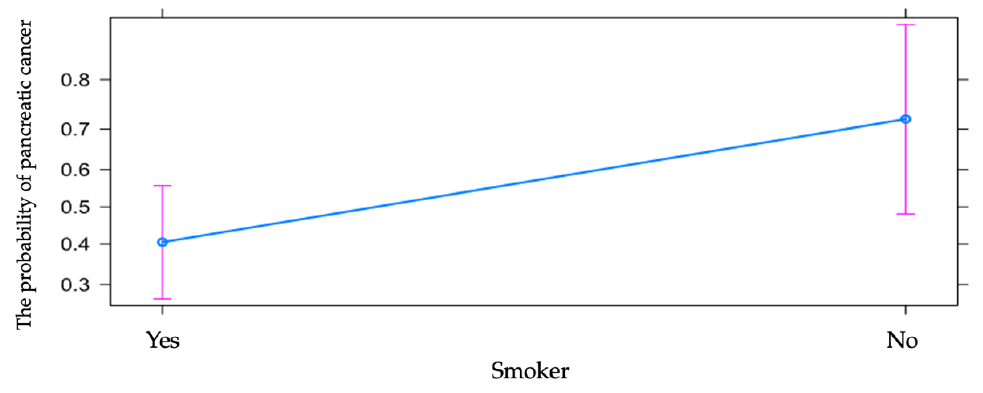
Figure 5. The influence of smoking on the risk of pancreatic cancer vs. chronic pancreatitis. Alcohol consumption represents one of the most important risk factors involved in the occurrence of pancreatic cancer. However, the analysis by comparison showed the odds of cancer vs. chronic pancreatitis to be almost five times higher in patients who de- nied alcohol consumption when compared to patients who confirmed alcohol consump- tion, with the effect being statistically significant. The relative risk ratio was 1.93 (calcu- lated with 10,000 bootstrap samples), with 95% CI 1.20 to 3.20, so that in the studied group, the risk ratio of pancreatic cancer vs. chronic pancreatitis was 1.93 times higher among patients who denied alcohol consumption vs. patients who affirmed chronic alcohol con- sumption (Table 1 and Figure 6). Figure 6. The influence of alcohol consumption on the risk of pancreatic cancer vs. chronic pancre- atitis. Regarding the influence of history of acute pancreatitis, the odds of pancreatic cancer vs. chronic pancreatitis were 45 times higher in patients without a personal history of acute pancreatitis, with the effect being statistically significant. The relative risk ratio was 7.87 (calculated with 10,000 bootstrap samples), with 95% CI 3.44 to 83.70, so that in the studied group a history of acute pancreatitis was associated with a higher risk of evolution to chronic pancreatitis than to pancreatic cancer (Table 1). Regarding the history of type 2 diabetes, the odds of pancreatic cancer vs. chronic pancreatitis were approximately two times lower in patients without a personal history of type 2 diabetes, but the effect had no statistical significance. The relative risk rate was 0.75 (calculated with 10,000 bootstrap samples), with 95% CI 0.45 to 1.30, so that in the studied group, the risk rate of pancreatic cancer vs. chronic pancreatitis was 25% lower